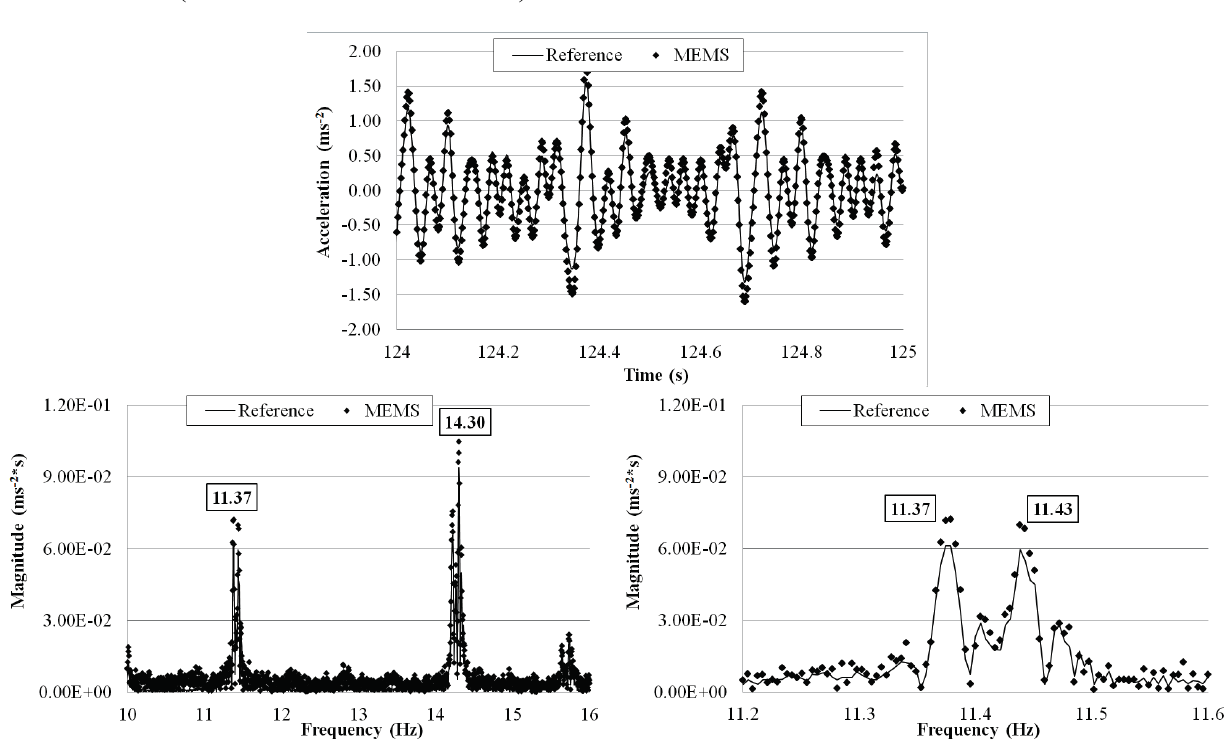
Figure 28. Comparison of measurements by the two sensors in time and frequency domains (2.00 × 10 − 3 m 3 ·s − 1 flow